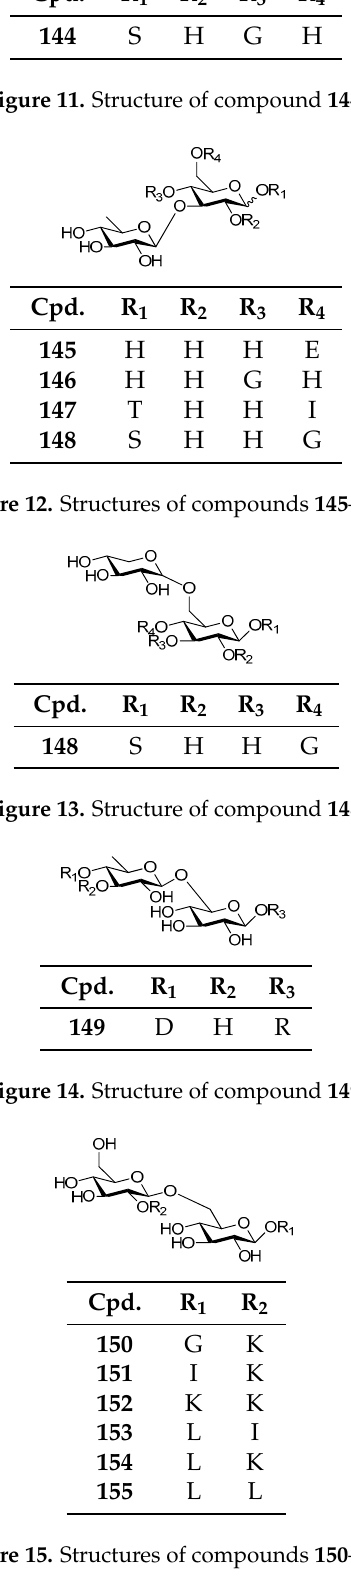
Figure 15. Structures of compounds 150 – 155